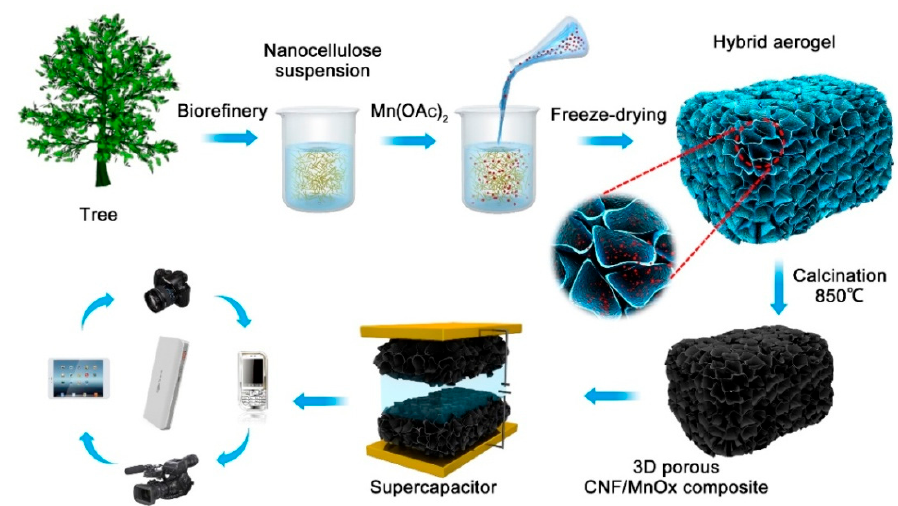
Figure 1. Schematic illustration of the preparation procedure of 3D porous carbonized nanocellulose fibers (CNF)/MnO x composite electrodes for supercapacitor applications.